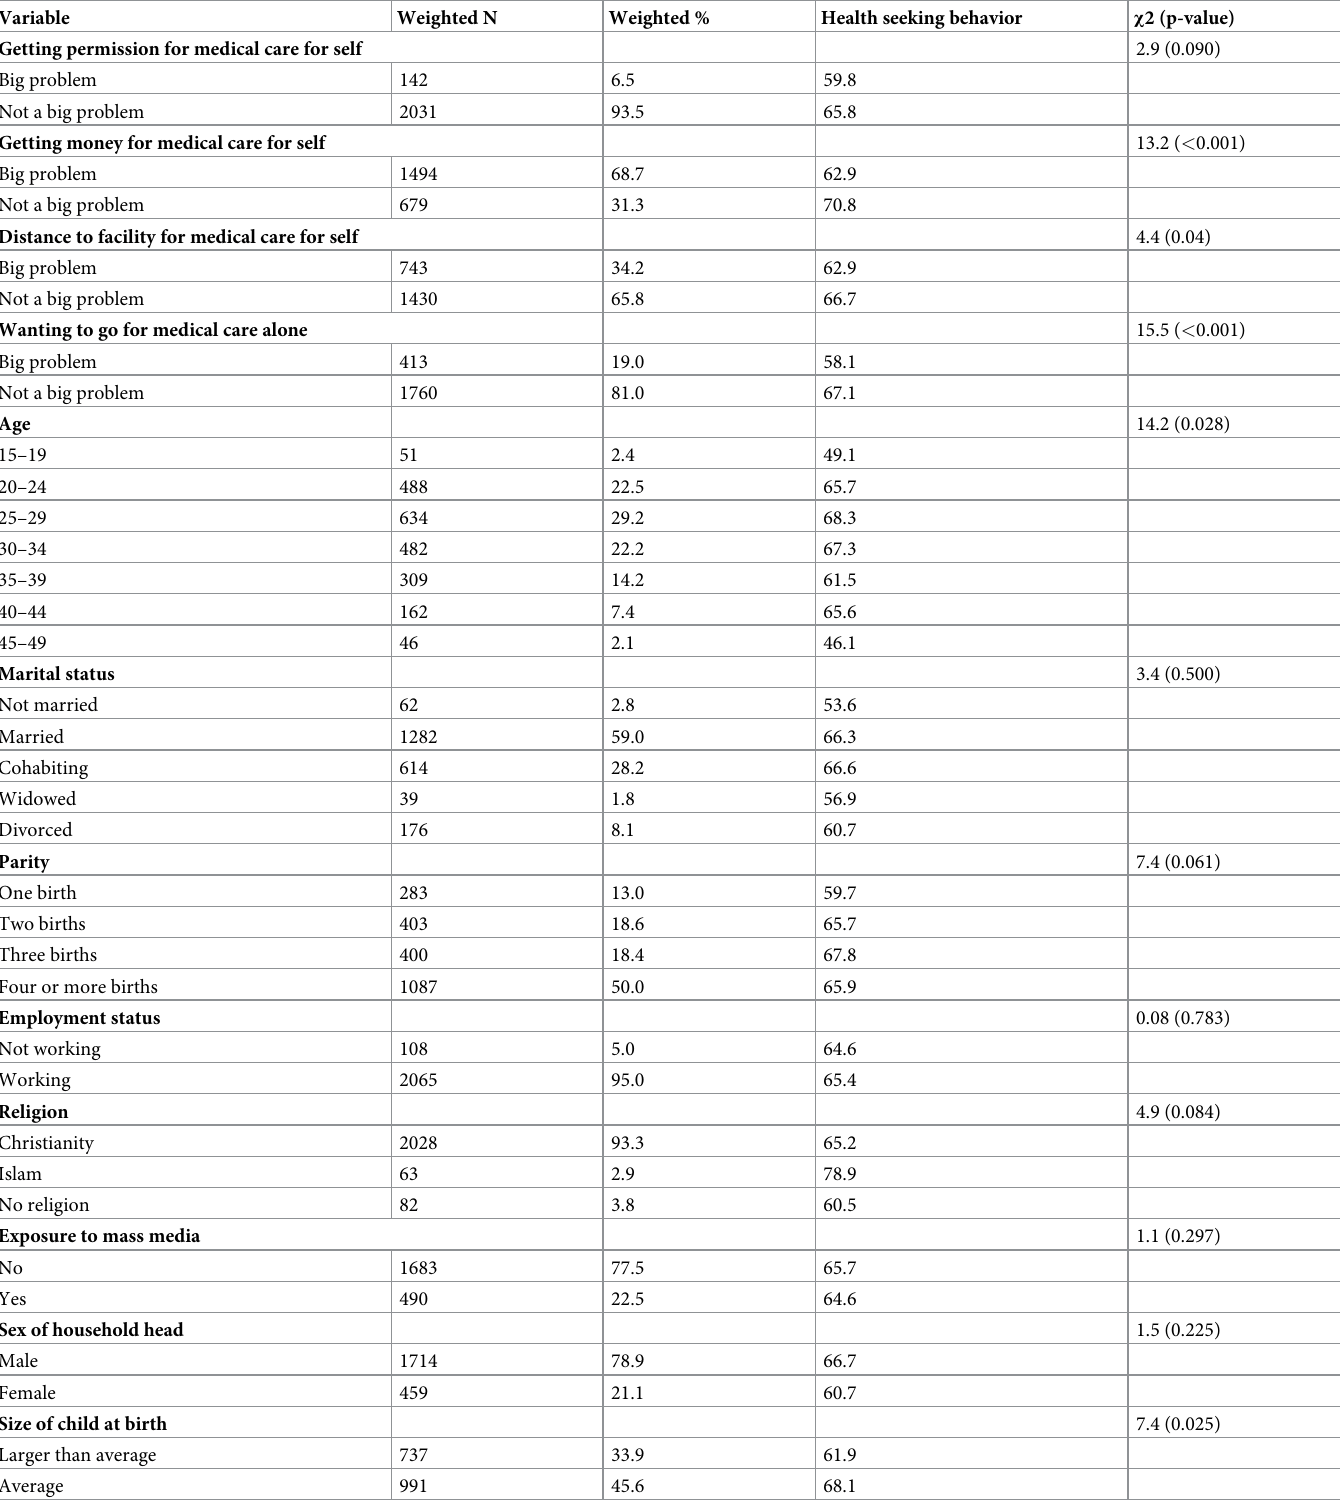
Table 1. Healthcare seeking behavior for childhood illness across independent